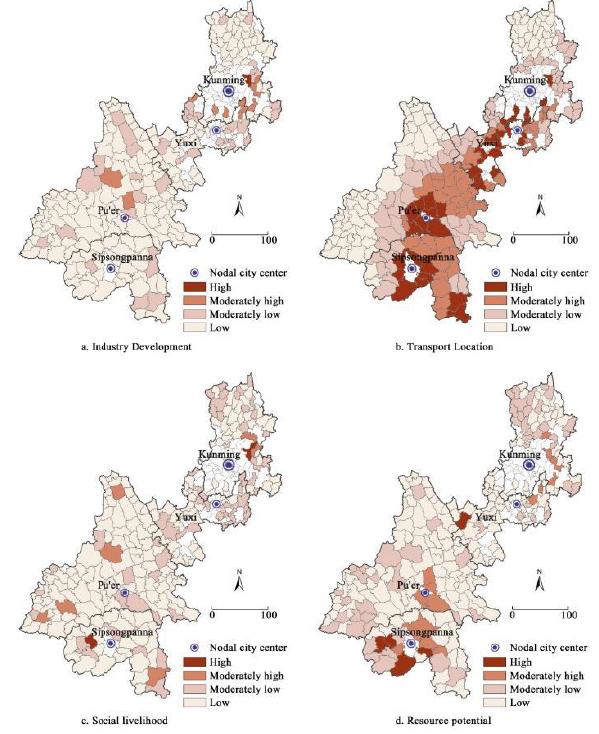
Figure 2. Results of classification assessment.